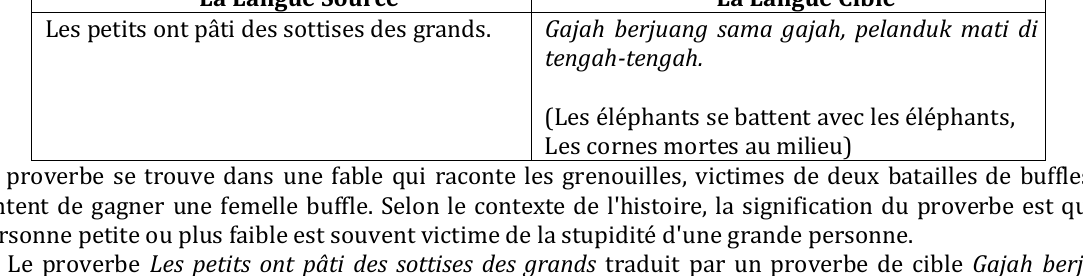
Tableu 1 La traduction est le proverbe de la langue cible Les petits ont pâti des sottises des